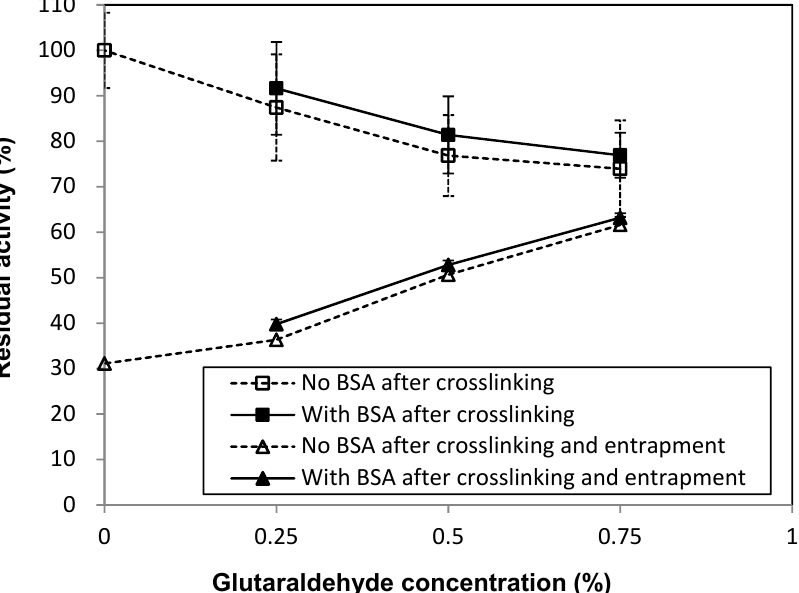
Figure 1. Residual activity of BG after glutaraldehyde cross-linking (3 replications)